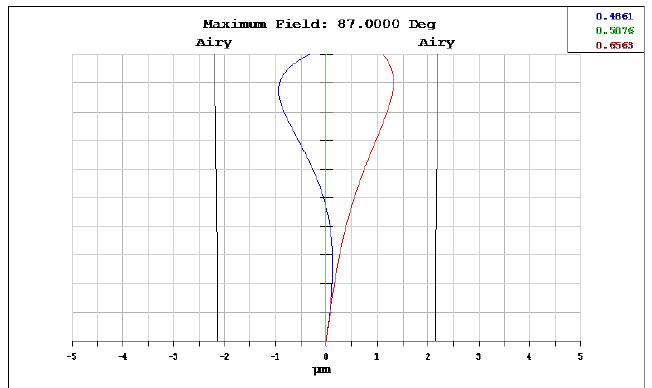
using a polymethyl methacrylate (PMMA) aspheric lens.